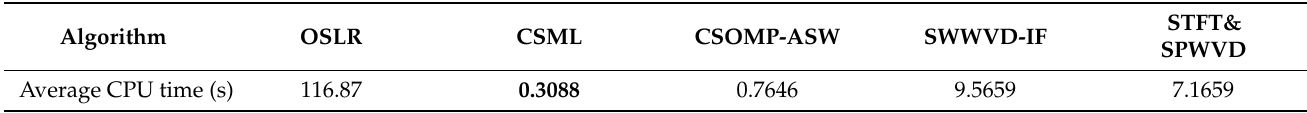
Table 5. The average CPU time consumed by the five algorithms in the process of estimating the hopping